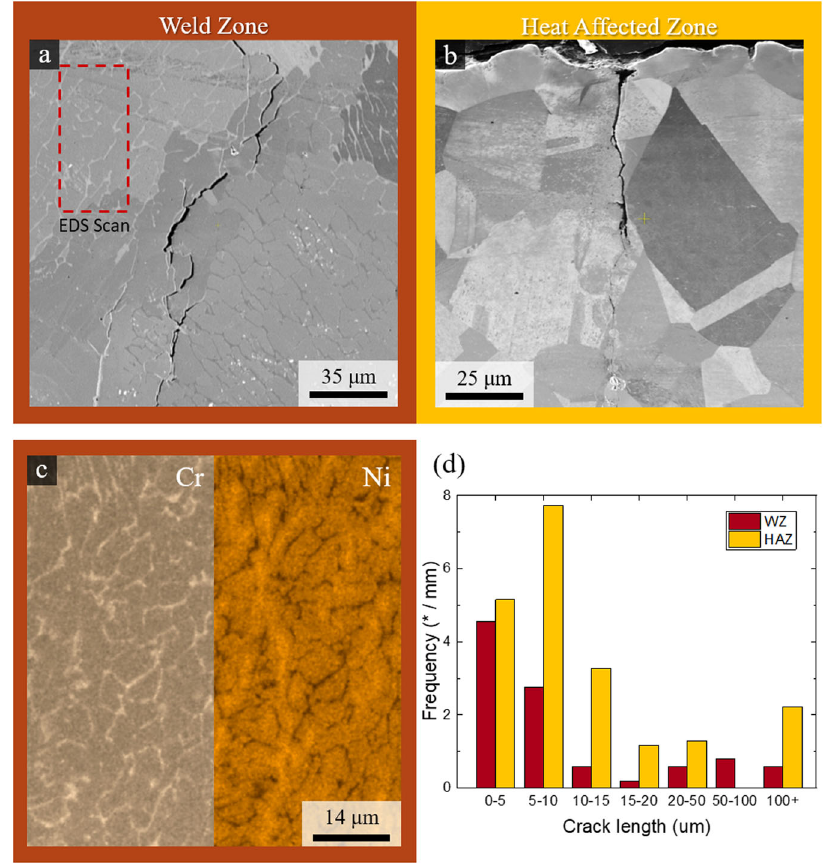
Fig. 2 Crack morphology. a HAZ and b WZ; c EDS map of WZ shows precipitation along subgrain boundaries: Ni depletes while Cr enriches at the subgrain GBs; d crack length distribution in HAZ and WZ on the ND – LD plane of the sectioned